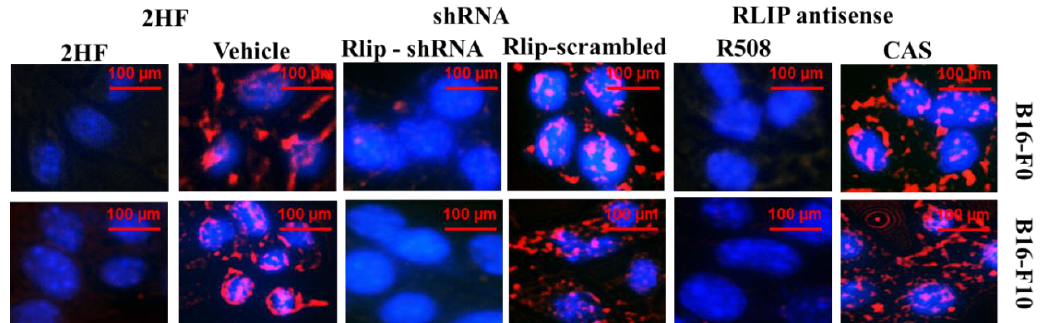
Appendix Figure A1. Effects of Rlip depletion on EGF endocytosis of B16-F0 and B16-F10 cells. High magnification views are shown demonstrating the inhibitory effect of 100µM 2HF and of Rlip-depletion on endocytosis of EGF-pHrodo. Procedures used are explained in Materials and Methods Section.